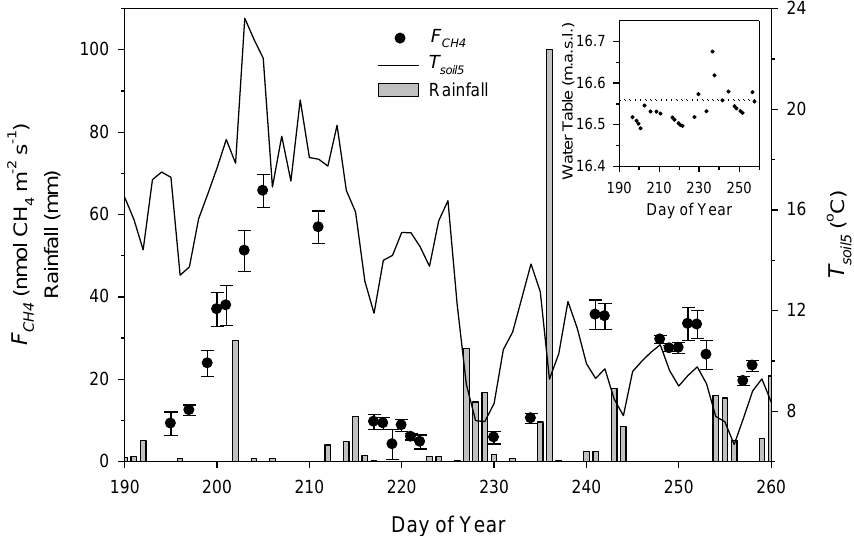
Fig. 4. Growing season mean daily F CH (no gap-filling) ( n = 3 to 42) ± 1SE shown, mean daily T soil5 and total daily rainfall for the fen 4 from 9 July to 17 September 2010 (DOY 190–260). Inset Figure: mean daily water table height for the fen 14 from 9 July to 17 September 2010 (DOY 190–260). Dotted line indicates the mean peat surface